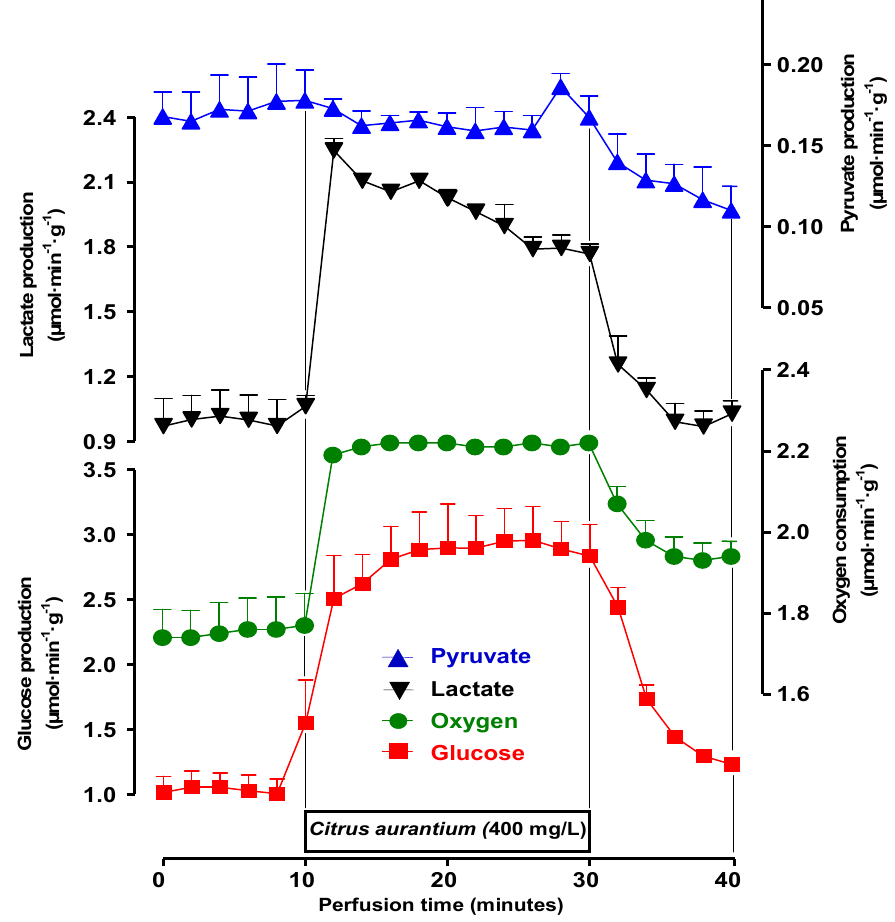
Figure 2. Time courses of the changes caused by the C. aurantium extract (400 mg/L) on glycogen catabolism and endogenous fatty acids-driven oxygen uptake. Livers from fed rats were perfused as described in the Experimental Section. C. aurantium (400 mg/L) was infused during 20 min, as indicated by the horizontal bar. The ef fl uent perfusate was sampled in 2-min intervals and analyzed for glucose, lactate, and pyruvate. Oxygen consumption was followed polarographically. Each datum point represents the means of three liver perfusion experiments. Bars are standard errors of the